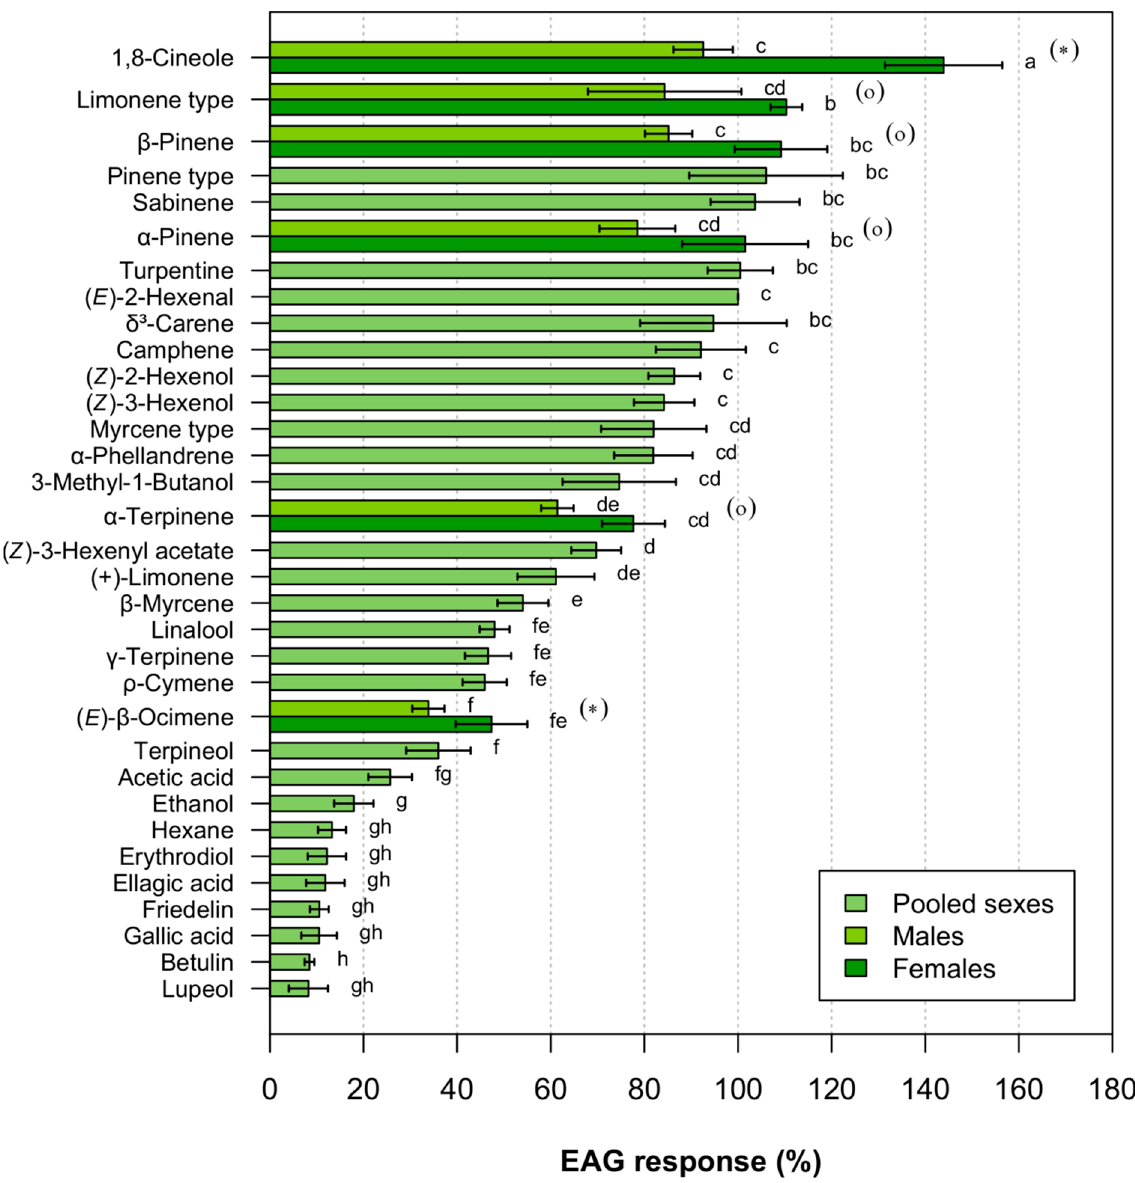
Figure 1. Mean 0.2 (± Error 0.2 ) EAG responses of Cerambyx welensii Küster to tree volatiles. Responses are expressed as normalized percentages relative to the standard stimulus (( E )-2-hexenal), after subtracting the response to the hexane control. The response to the hexane control is included for comparison. Bars with the same letter were not significantly different ( p > 0.05, heteroscedastic ANOVA; bootstrap version of Yuen’s test). Odorants that elicited EAG responses that differed between sexes are indicated with an asterisk or a circle (significant or marginally significant, respectively; bootstrap version of Yuen’s test or Mann-Whitney U -test).